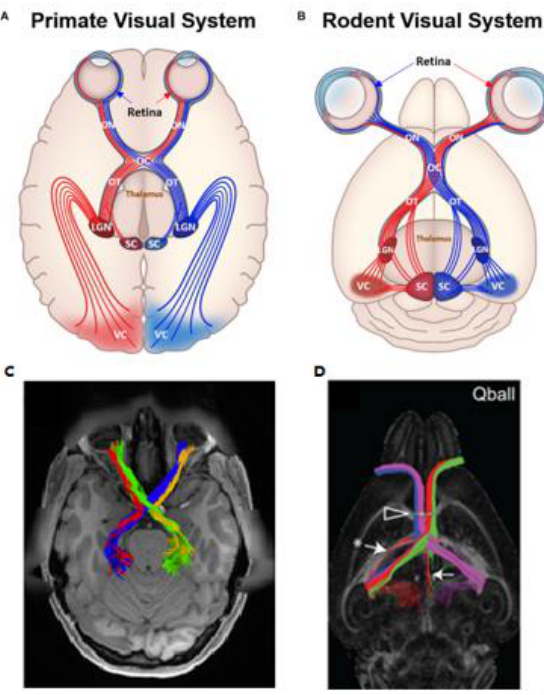
Figure 1. Representative illustrations (top) and diffusion MRI tractography (bottom) of primate ( A , C ) and rodent ( B , D ) visual systems. Visual structures including the retina, optic nerve (ON),